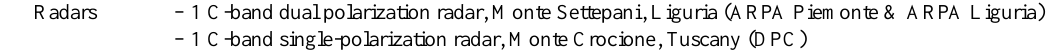
Table 2. Instrumentation deployed over the LT area during SOP1 (in parentheses the responsible institutions). Radars